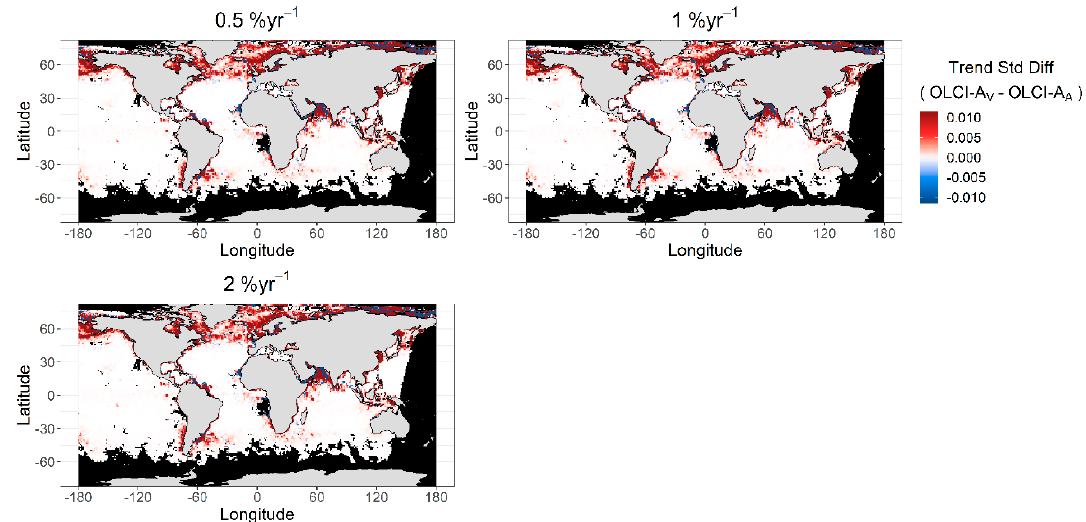
Figure A4. Global 1° maps of the differences between the standard deviation of all chl- a trend estimates from all bootstraps for OLCI-A-Aligned and OLCI-A-Vicarious in each grid cell. The value expressed in percent per year above each subplot indicates the trend imposed on the synthetic time series. Red indicates that OLCI-A-Vicarious has higher standard deviation of chl- a trend estimates than OLCI-A-Aligned. Black grid cells indicate where missing data prevents analysis.